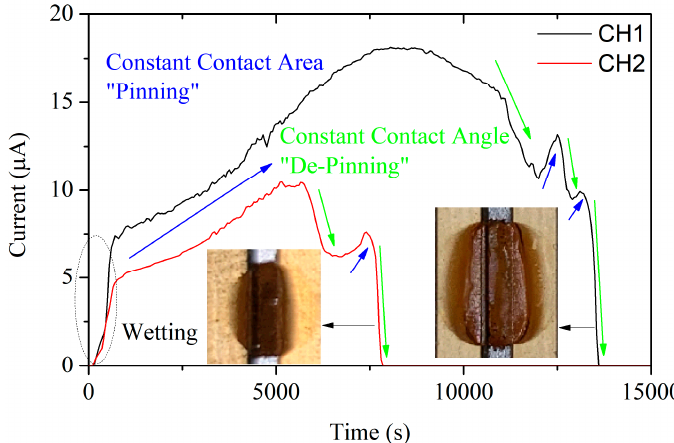
Figure 7. Comparison of two current curves under wetting by two wider droplets.